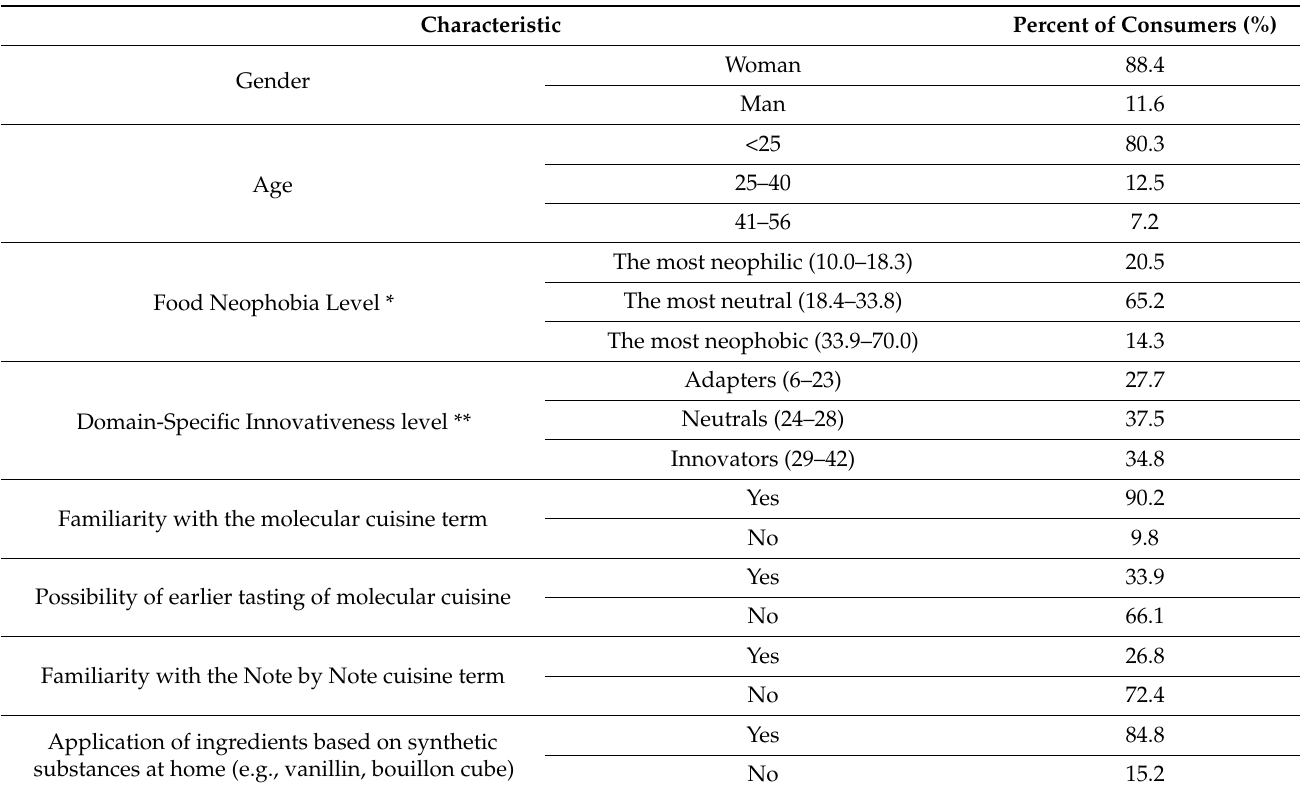
Table 2. Characteristic of participants ( n =